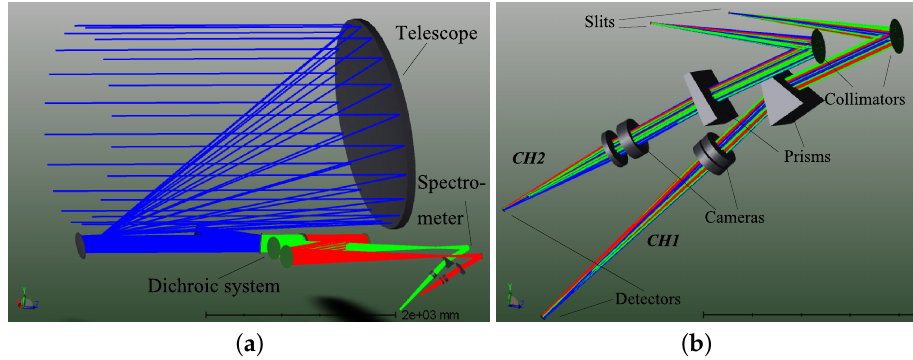
Figure 10. ( a ) Overall structure of optical system, including telescope, dichroic system, and spectrom- eters. FGS, CH1, and CH2 channels represented by blue, green, and red, respetively. ( b ) Spectrometer details in the optical system. Different light colors distinguish wavelengths in each